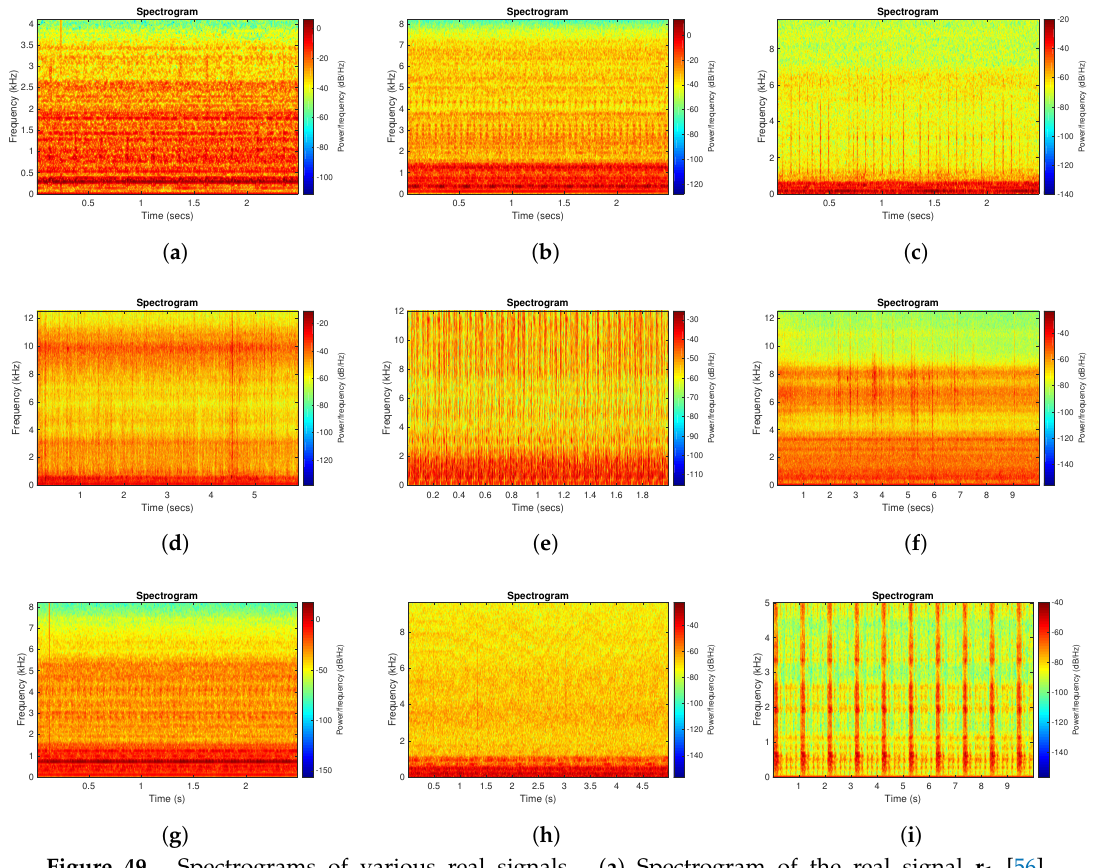
Figure 49. Spectrograms of various real signals. ( a ) Spectrogram of the real signal r 1 [56]. ( b ) Spectrogram of the real signal r 2 [57]. ( c ) Spectrogram of the real signal r 3 [5]. ( d ) Spectrogram of the real signal r 4 [44]. ( e ) Spectrogram of the real signal r 5 [28]. ( f ) Spectrogram of the real signal r 6 . ( g ) Spectrogram of the real signal r 7 . ( h ) Spectrogram of the real signal r 8 . ( i ) Spectrogram of the real signal r 9